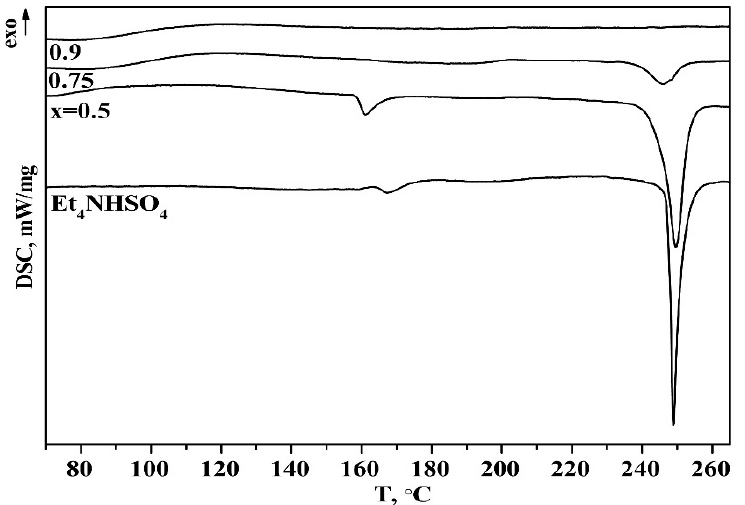
Figure 5. D SC data for Et 4 NHSO 4 and (1 − x)Et 4 NHSO 4 − xSiO 2 composites with different composi ‐